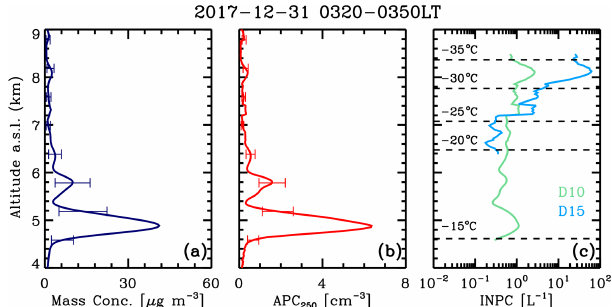
Figure 12. Profiles of the (a) dust mass concentration M d , (b) par- ticle number concentration APC 250 , and (c) ice-nucleating particle concentration derived by the POLIPHON method (D10 and D15 parameterizations) during 03:20–03:50LT on 31 December 2017. Horizontal dashed lines denote the temperature height levels of − 15, − 20, − 25, − 30, and − 35 ◦